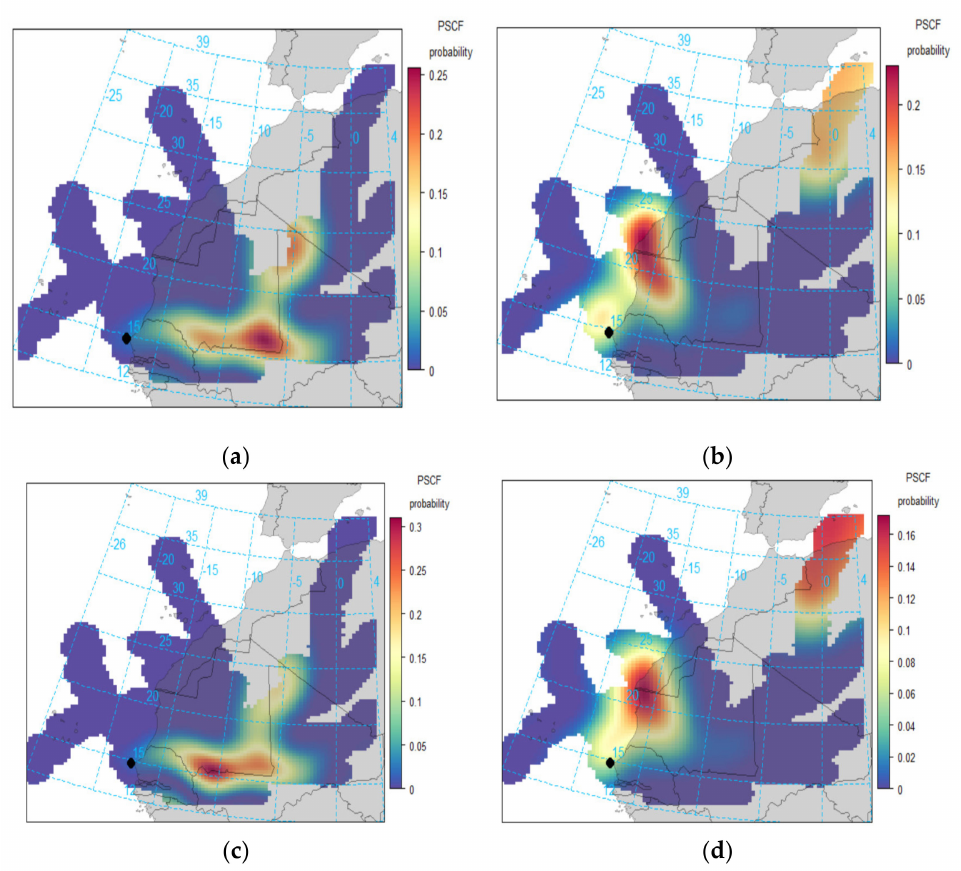
Figure 5. Potential Source Contribution Functions (PSCFs) for the 85th percentile of ( a ) PM 2.5 to Hlm, ( b ) PM 2.5–10 to Hlm, ( c ) PM 2.5 to Yoff and ( d ) PM 2.5–10 to